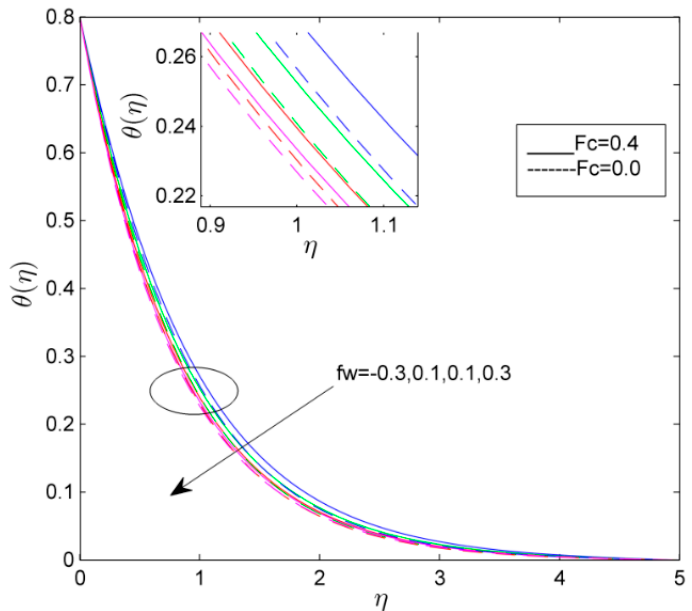
Figure 9. Effect of heat generation parameter ( H A ) on θ ( η ) .